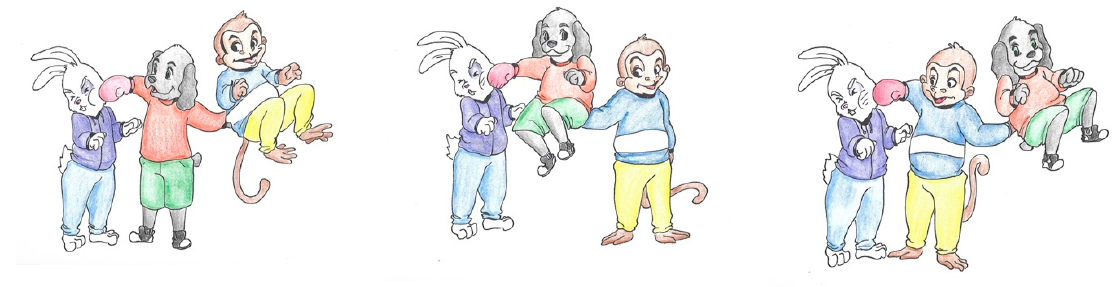
Figure A22. ORC stimulus 7.